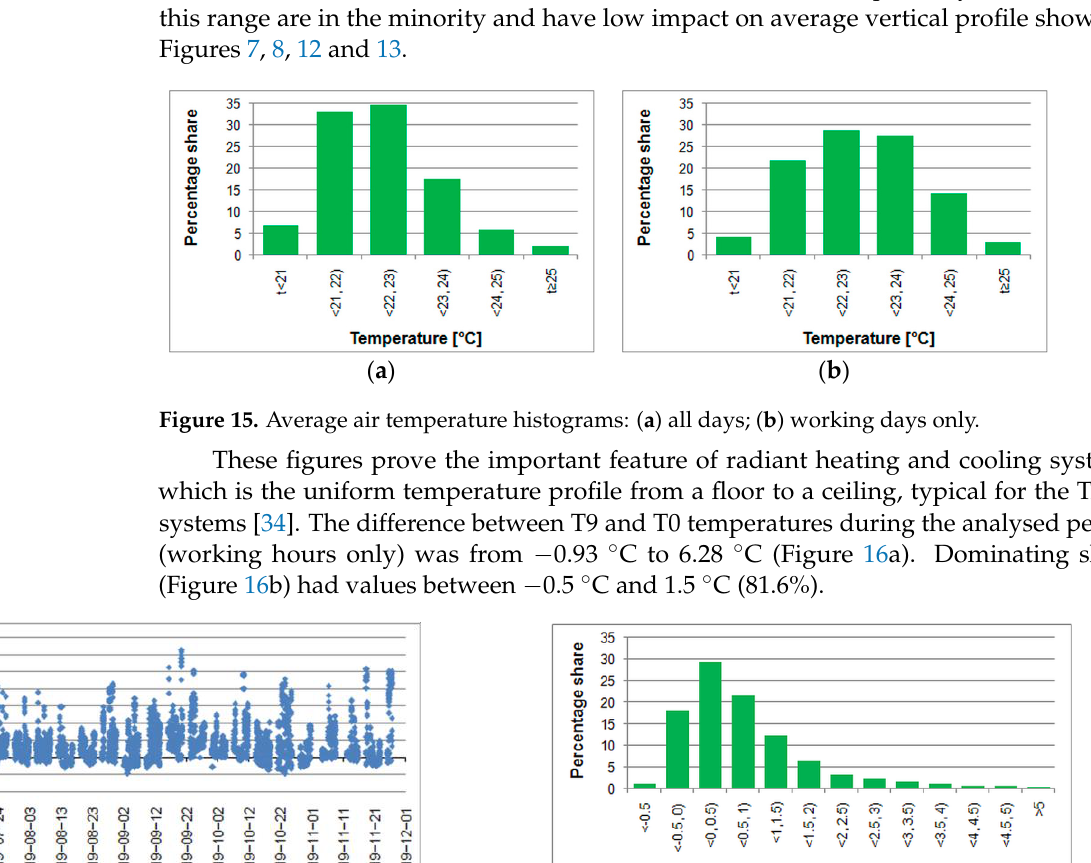
Figure 14. Internal air temperature distribution during working hours. The average internal air temperature was of 21.8 °C and 22.9 °C for all and working days, respectively. Taking as reference the average for the whole period the average temperature stratification was 0.83 K. In order to estimate the variability of the measured air temperature value in the examined profile from its average values, its histograms were determined for all days and working days (Figure 15). Temperature from 21 °C to 24 °C had dominant share of 85.3% and 78.3% in the first and second case, respectively. Values outside this range are in the minority and have low impact on average vertical profile shown in Figures 7, 8, 12 and 13.